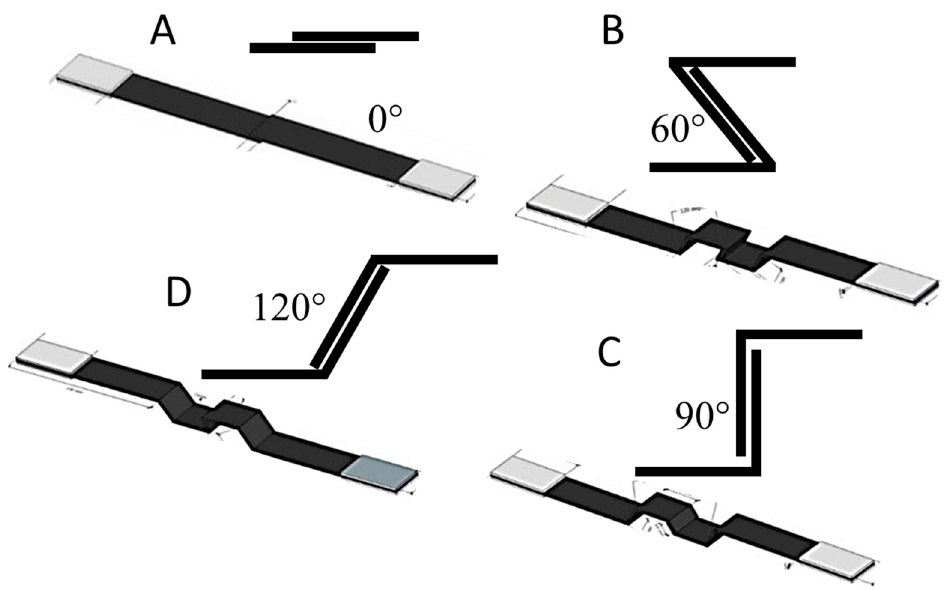
Figure 1. Schematic drawings of each of the different joint configurations: ( A ) single-lap joint; ( B ) 60° joint configuration; ( C ) 90° joint configuration; and ( D ) 120° joint configuration.